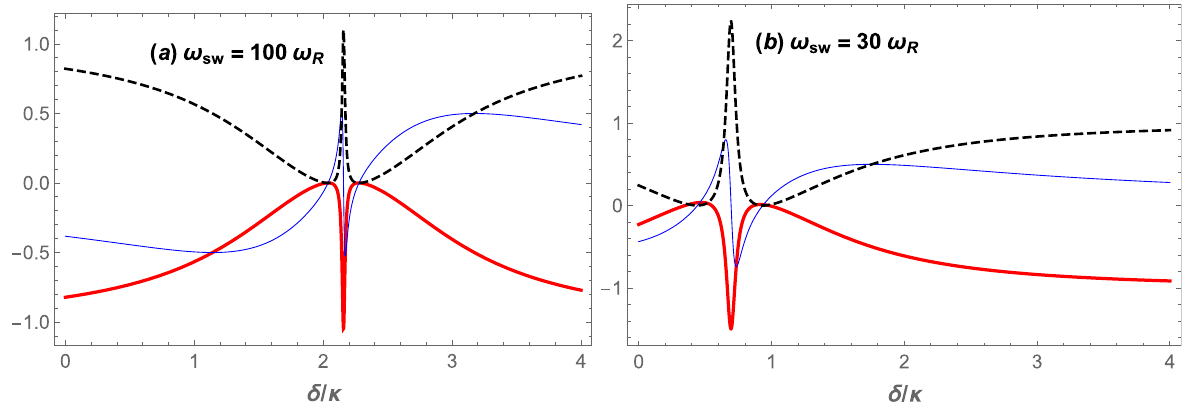
Figure 3. (Color online) R e [ ε R ] (red thick curve) and I m [ ε R ] (blue thin curve) as well as the cavity power reflection coefficient R (black dashed curve) at the signal frequency versus the normalized frequency detuning ( δ/κ ) for the coupling laser pumping rate of | ε c | = 0.10 κ , in the red detuning regime of � = ω B for two different values of the s -wave scattering frequency: ( a ) ω sw = 100 ω R , and ( b ) ω sw = 30 ω R . The other parameters are the same as those of Fig.